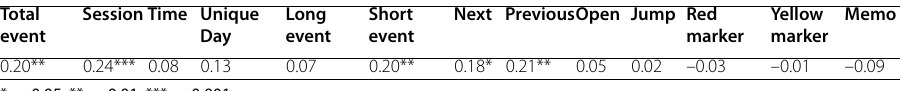
Table 5 Description of features for calculating